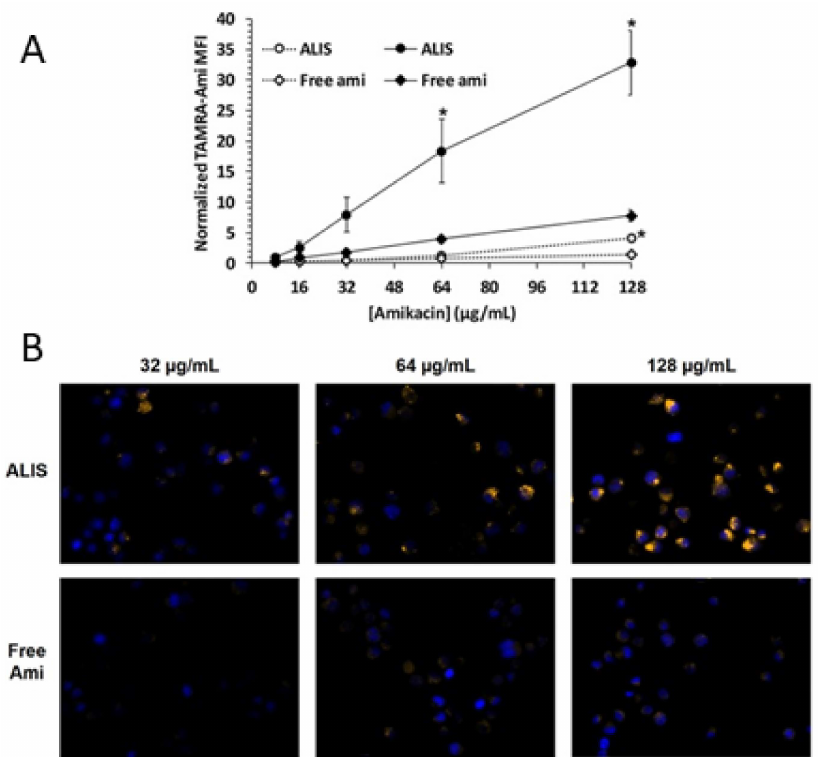
Figure 8. Liposomal and free amikacin uptake into human macrophages. Macrophages were exposed to increasing concentrations of either ALIS or free amikacin (with addition of 0.44% tetramethyl rhodamine (TAMRA) conjugated amikacin) for 4 h (gray symbols) or 24 h (black symbols). ( A ) nor- malized mean fluorescence intensity (MFI) at each concentration averaged from three independent experiments. ( B ) Visualization of liposomal and free amikacin uptake in human macrophages by fluorescence microscopy. TAMRA fluorescence was visualized by a Zeiss Axio fluorescence micro- scope (400 × magnification) using constant settings for all experimental conditions. Yellow: TAMRA amikacin; Blue: DAPI-stained DNA. * p < 0.05 vs. free amikacin at the same concentration and timepoint. Adapted from [149]. Frontiers, 2018. Furthermore, tissue and pulmonary macrophage exposures were compared in vivo after the 96 mg/kg amikacin dose delivered by ALIS nebuliza- tion versus the 100 mg/kg amikacin dose given intravenously [149]. In pulmonary macrophages, maximum amikacin concentration (Cmax) after the ALIS dose was nearly 1.0 µ g/ µ g protein and the total macrophage exposure over 24 h (AUC) was 17.8 µ g*h/ µ g protein, 274-fold higher than the exposure following amikacin injection. Similarly, the BAL fluid and lung tissue exposures were 69.5- and 42.7-fold higher, respectively, after inhalation dosing of ALIS compared to intravenous dosing. Simultaneously, the systemic (blood plasma) exposure was 5-fold lower for ALIS than for amikacin